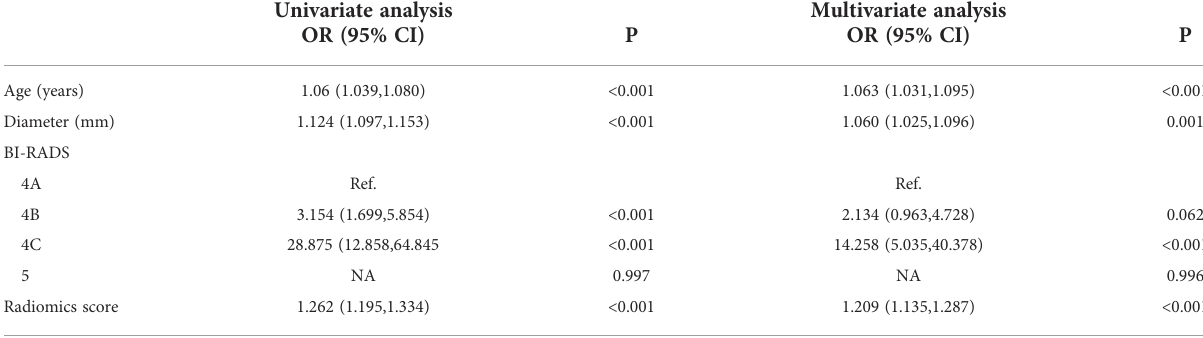
TABLE 2 Results of the univariate and multivariate analyses based on the development